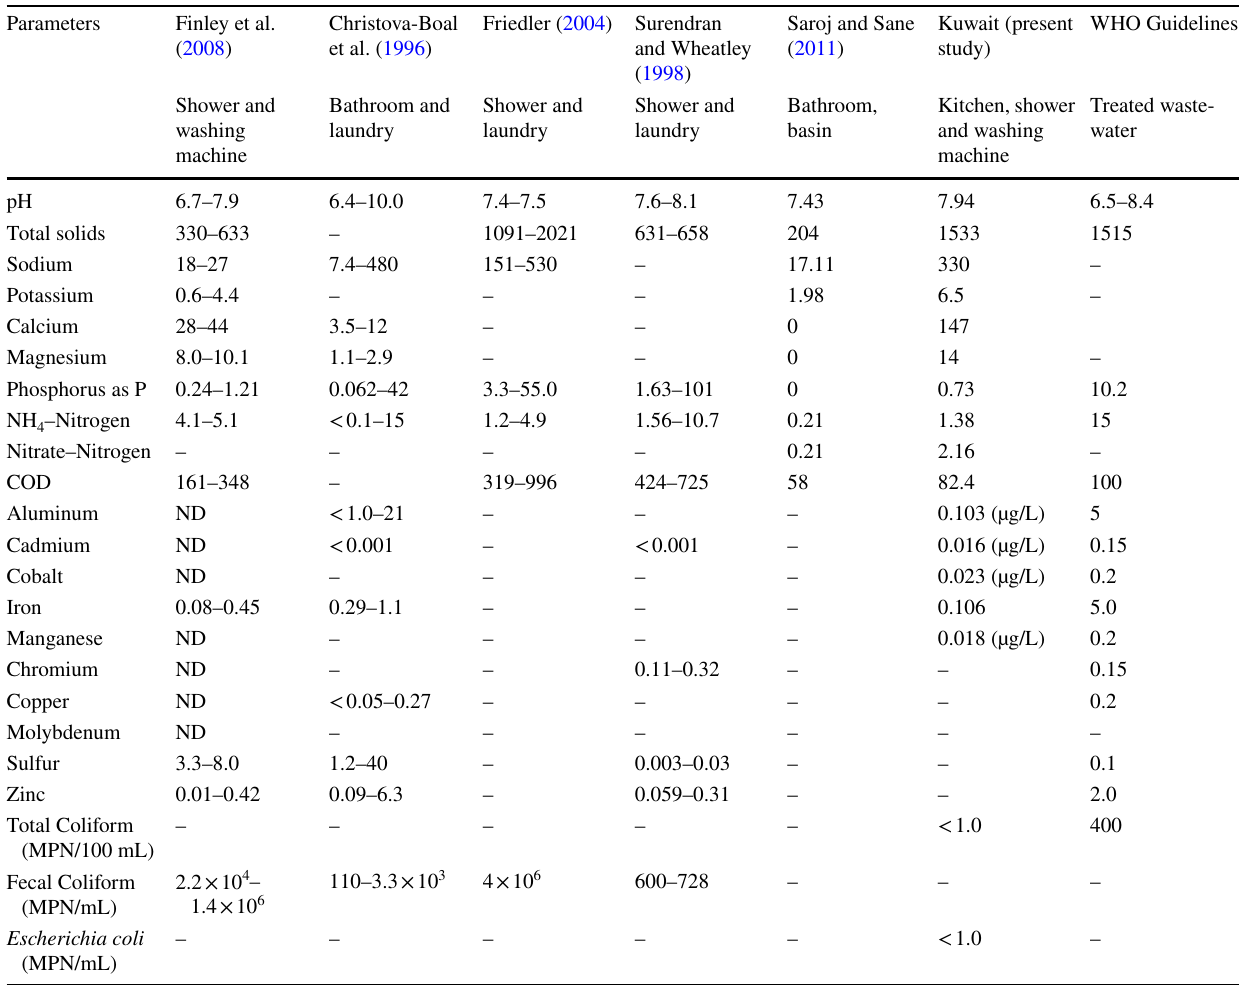
Table 4 Comparison of physical, chemical and microbiological quality of treated greywater with other reported studies (The values are in mg/L except for pH)